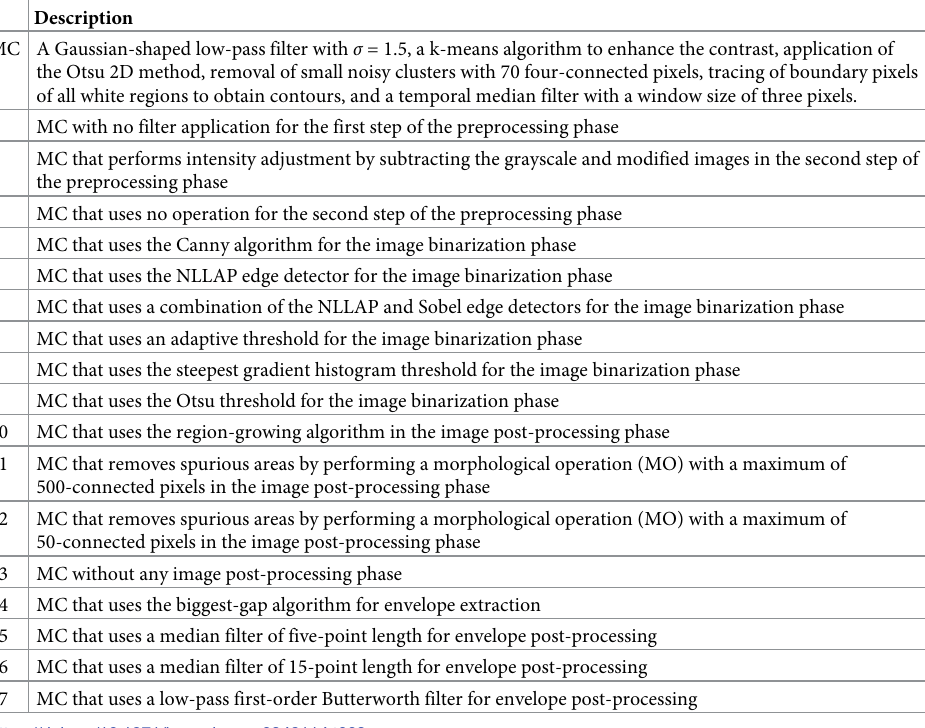
Table 2. Processing chains for assessment of individual steps. The numbering and description of the different pro- cessing chains created to assess the importance of individual steps in a prototypical processing chain. #